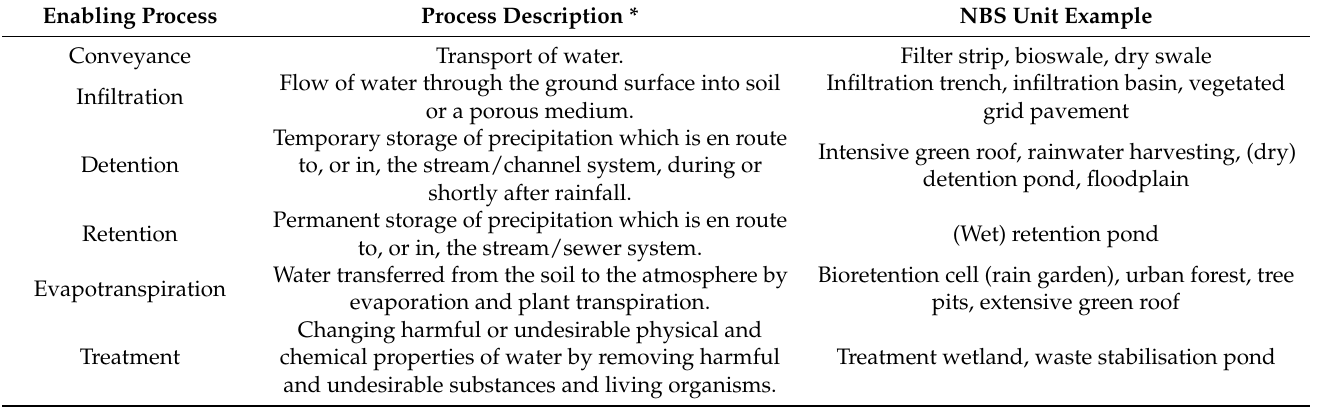
Table 2. Enabling processes for achieving UCC1: restoring and maintaining the water cycle.